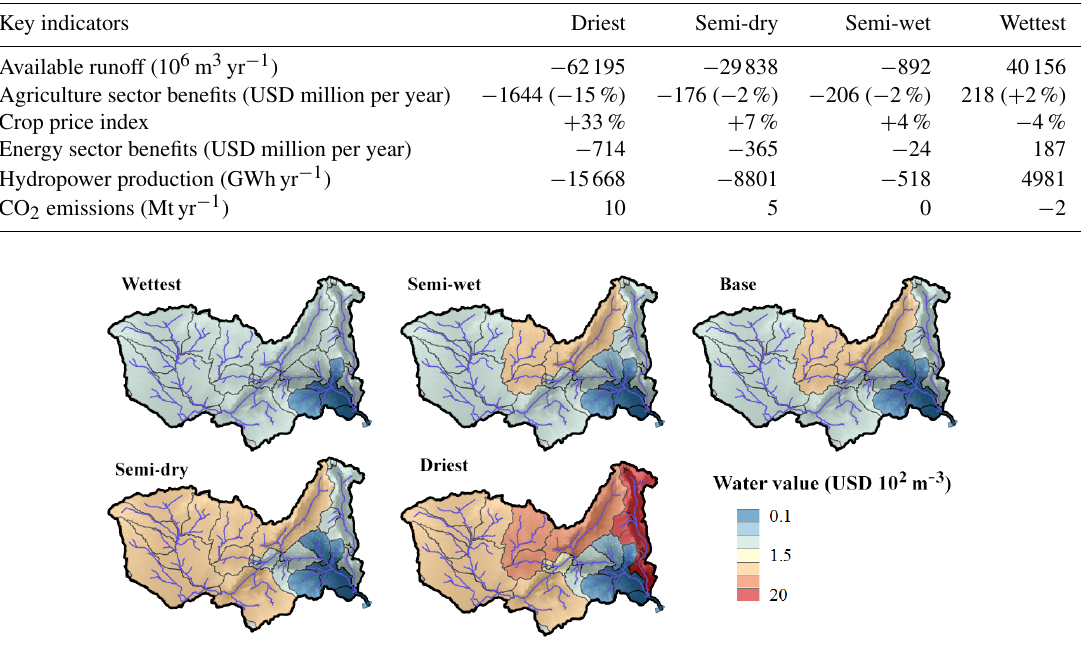
Figure 7. Average water value under climate change scenarios. The “water value” is the result of the shadow prices/dual values of the constraint of the hydro-economic model; it represents the potential economic benefits of an additional cubic metre (m 3 ) of water in the river. The increased water value is a sign of increased water